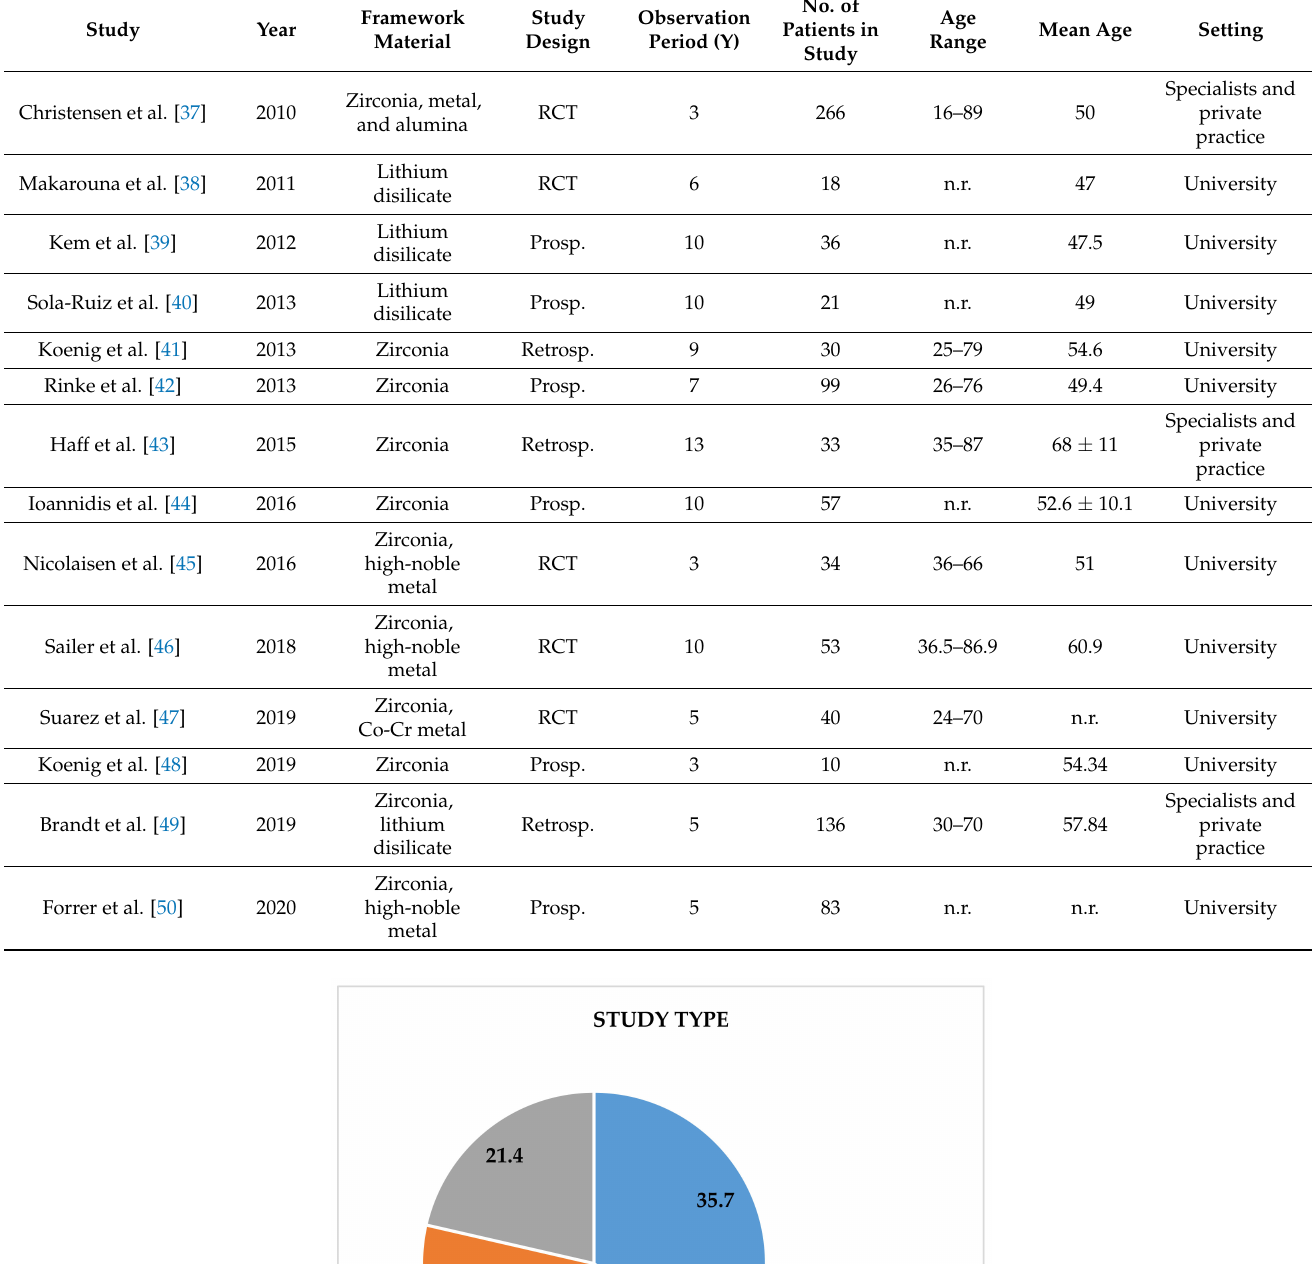
Table 1. Characteristics of the reviewed studies (RCT- Randomized control trial; Prosp-Prospective longitudinal study; Retrosp- Retrospective longitudinal study, n.r.- not reported).